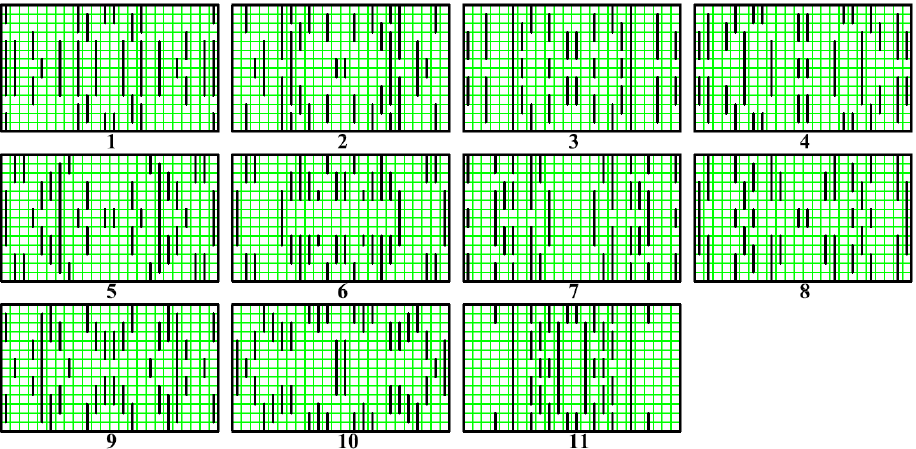
Figure 17. Artificial crack patterns with θ (90°).